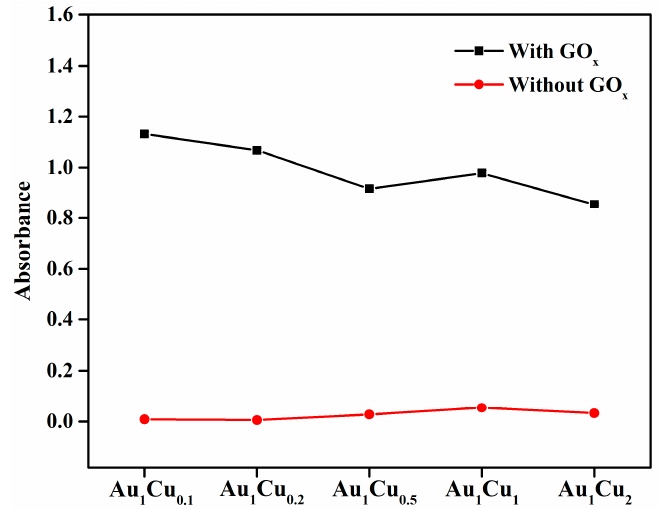
Figure 7. Ultraviolet-visible absorption intensity of 3,3 ′ ,5,5 ′ -tetramethylbenzidine (TMB) in the presence of glucose with and without glucose oxidase (GO x ). The concentration of glucose was 10 mM.